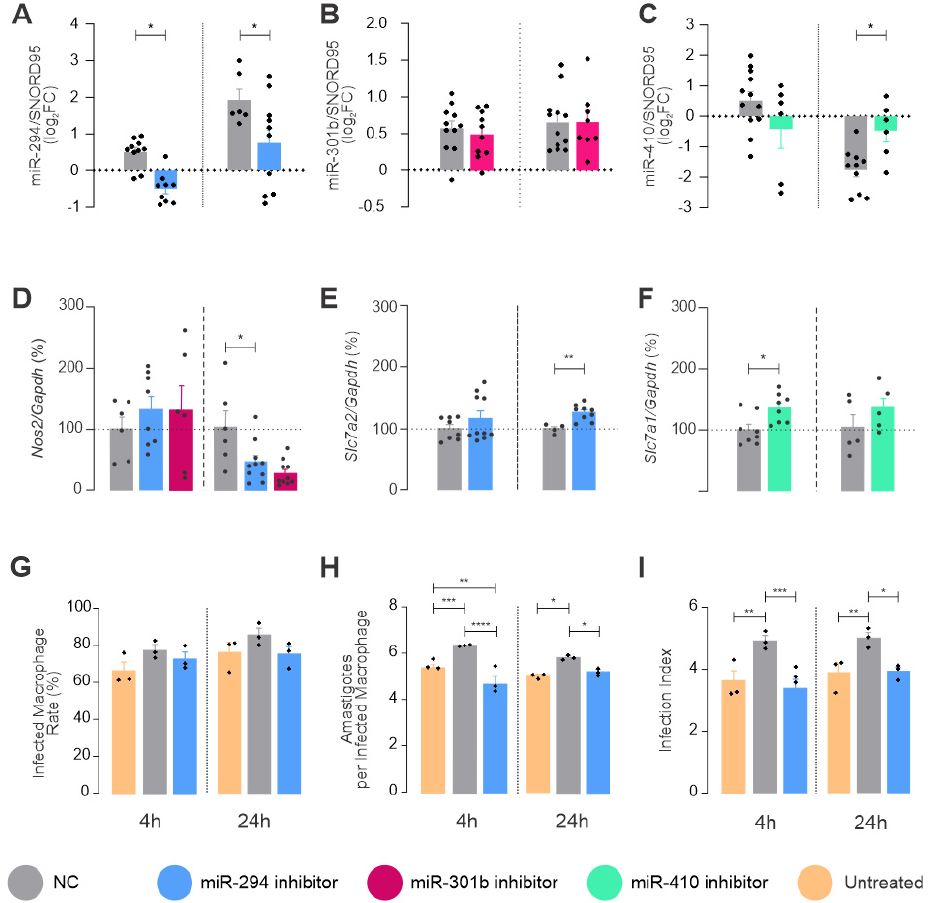
Figure 4. miRNA functional inhibition. Bone marrow derived macrophages were transiently trans- fected with specific miRNA inhibitors or negative control (NC) and were then infected with L. amazonensis for 4 or 24 h. Total RNA was extracted to quantify miRNA levels: ( A ) miR-294, ( B ) miR- 301b, and ( C ) miR-410; Or to assess the levels of mRNA targets after inhibition: ( D ) Nos 2, ( E ) Slc 7 a 22 and ( F ) Slc 7 a 1. The infected BMDM were fixed and Giemsa stained to assess the number of total macrophages ( n = 300), infected macrophages and amastigotes: (G) infected macrophage rate [(in- fected macrophage/total macrophage) ∗ 100], ( H ) amastigotes per infected macrophage, ( I ) infection index. Statistics: Each dot represents a biological replicate from three independent experiments. Mixed-effects analysis, post hoc test: Sidak’s multiple comparisons. p -values: *, p ≤ 0.05. **, p ≤ 0.001,